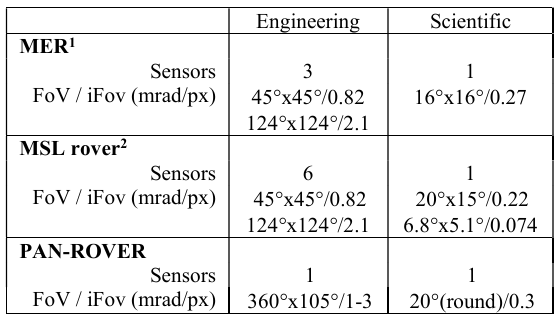
Figure 2 Bifocal lens scheme